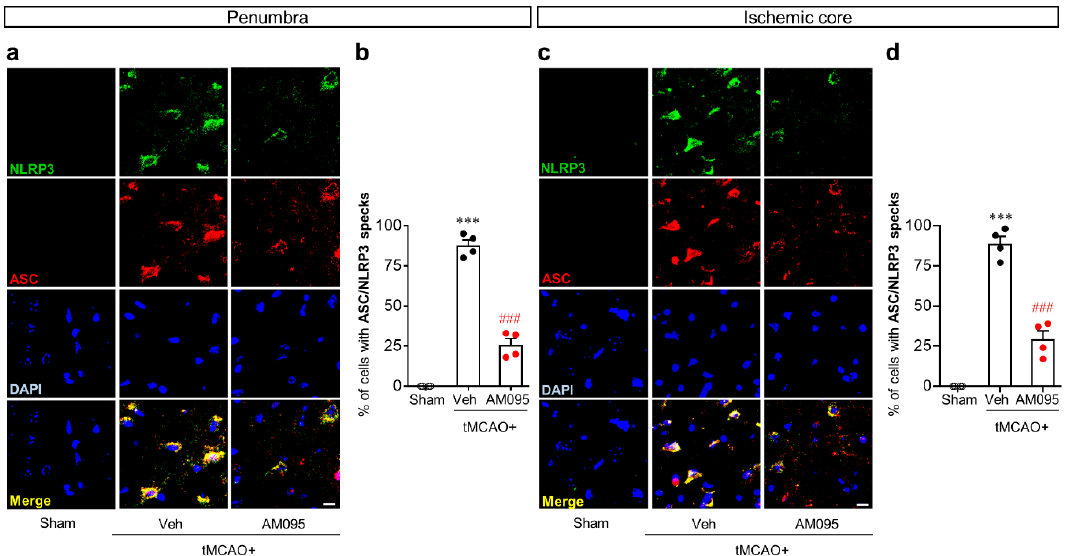
Figure 4. LPA 1 antagonist attenuates apoptosis-associated speck-like protein containing a caspase recruitment domain (ASC) speck formation in injured brains after tMCAO challenge. Mice were induced with tMCAO. AM095 (30 mg / kg) was administered immediately after reperfusion. ASC speck formation in NLRP3-immunopositive cells was determined in the penumbra and ischemic core regions at one day after tMCAO challenge by ASC / NLRP3 double immunofluorescence. Representative images of ASC / NLRP3 speck formation in the penumbra ( a ) and ischemic core regions ( c ) and quantification of their numbers in percentage ( b , d ) are shown. Scale bars, 10 µ m. n = 4 mice per group. *** p < 0.001 versus sham. ### , p < 0.001 versus vehicle-administered tMCAO group.